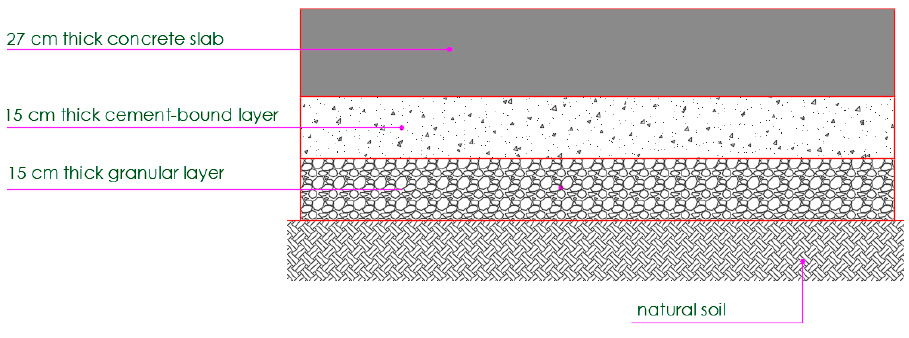
Figure 6. Pavement section.